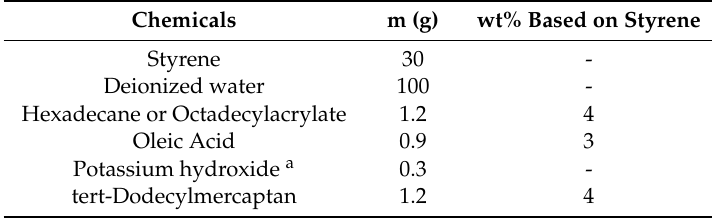
Figure 1. Schemeofproductionofstyrenebutadienerubber(SBR)latexesbyseededminiemulsionpolymerization. Figure 1. Scheme of production of styrene butadiene rubber (SBR) latexes by seeded miniemulsion polymerization. Table 1. Styrene miniemulsion Table 1. Styrene miniemulsion formulation.